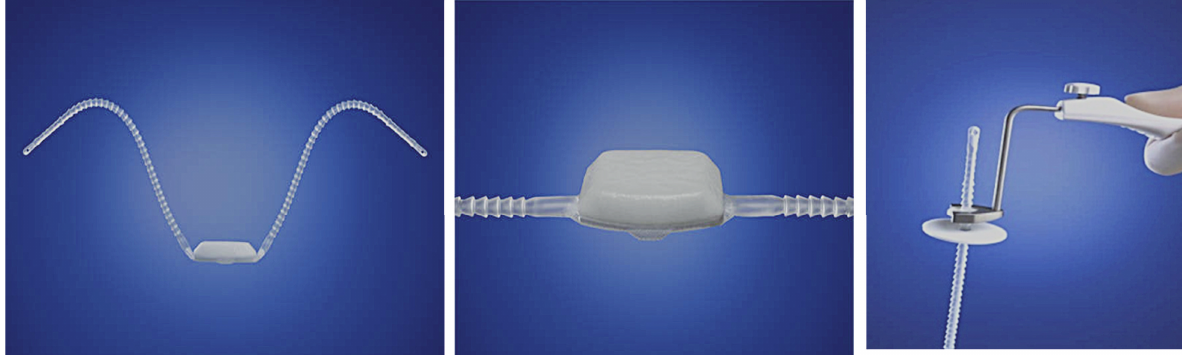
Figure 1 - ARGUS T adjustable system – Promedon